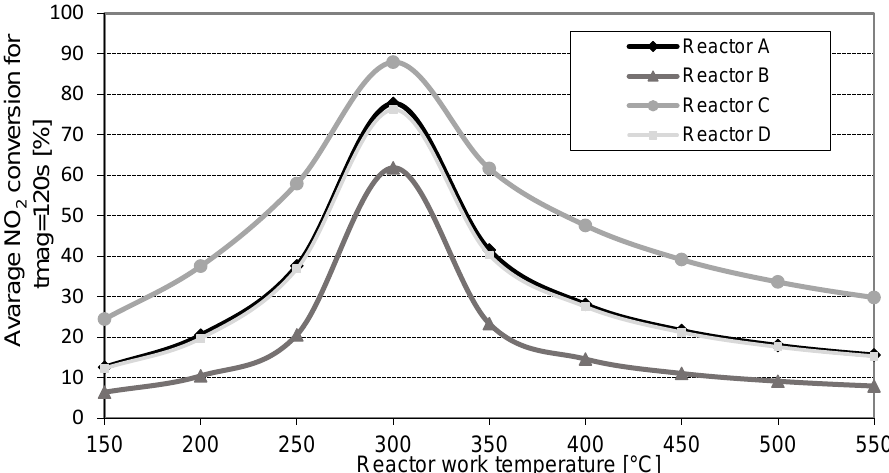
Figure 6. Changes in the average NO 2 conversion as a function of the operating temperature of reactors A, B, C, and D for the storage process of 120 s .